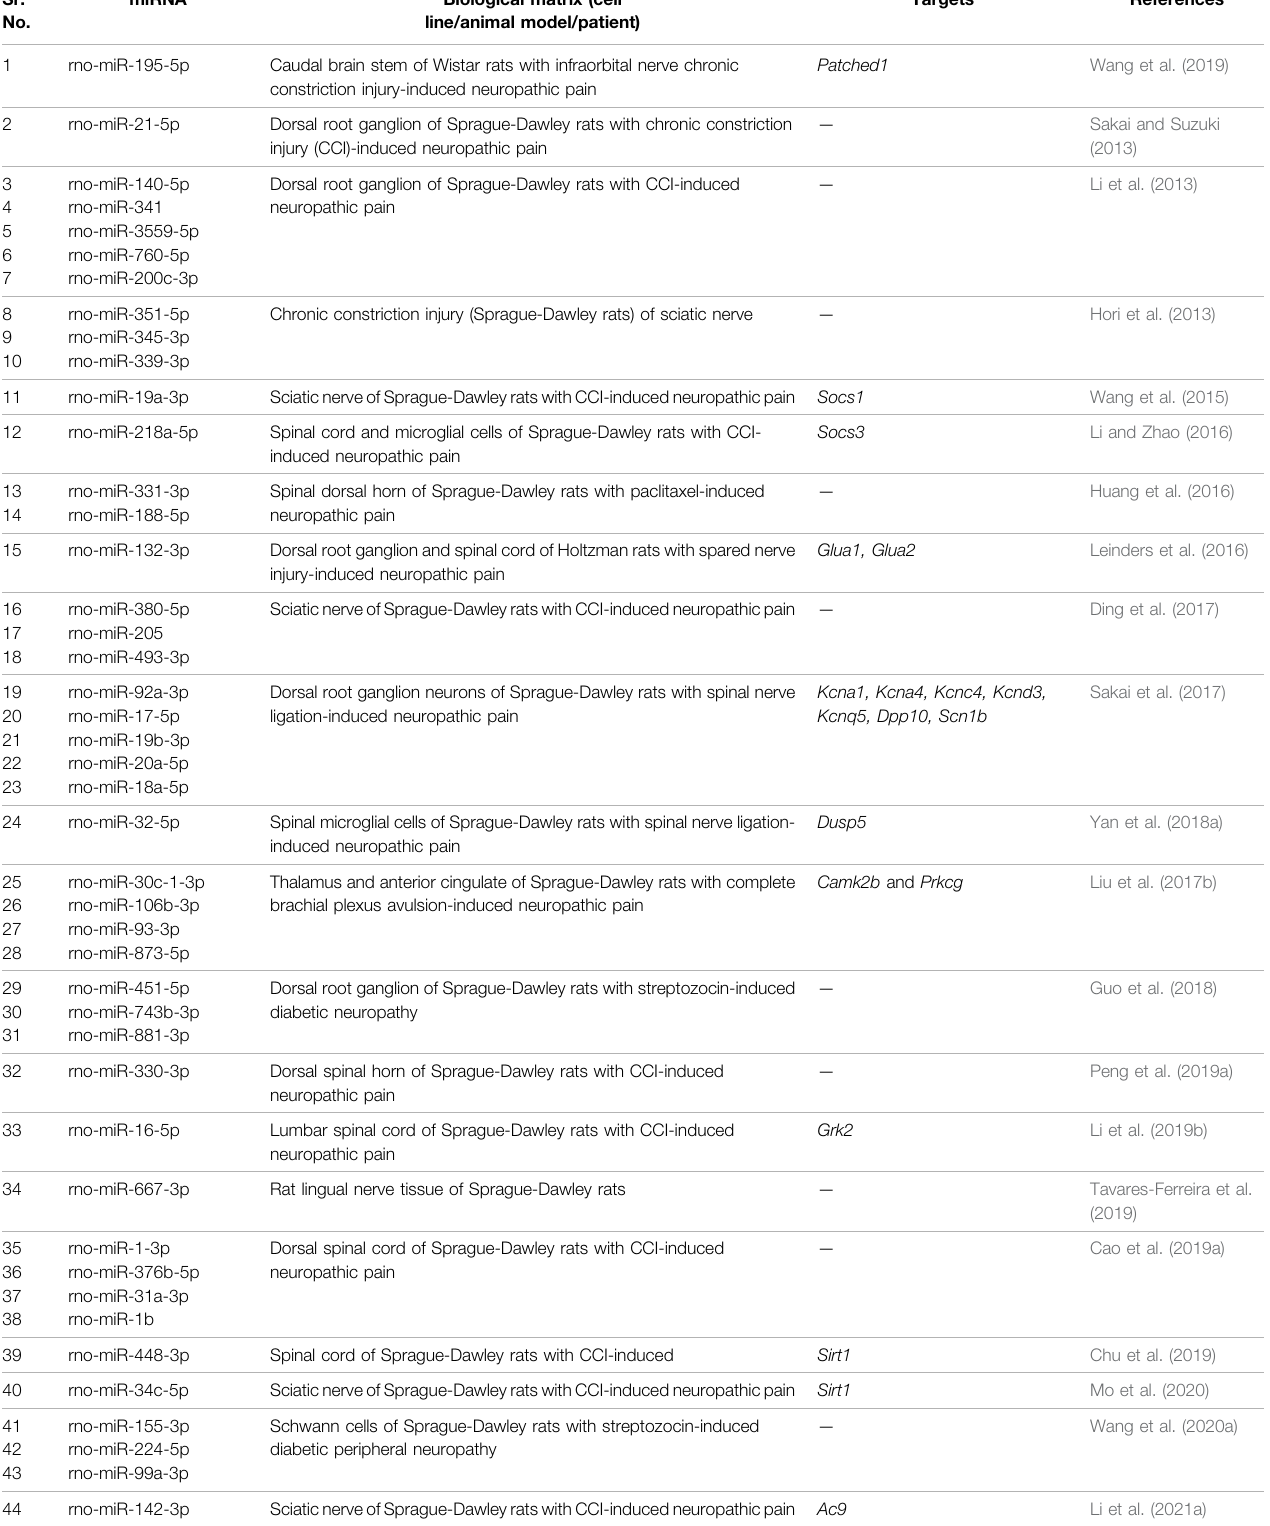
TABLE 3 | Upregulated rat microRNAs involved in neuropathic pain. Sr. miRNA Biological matrix (cell No. line/animal model/patient)